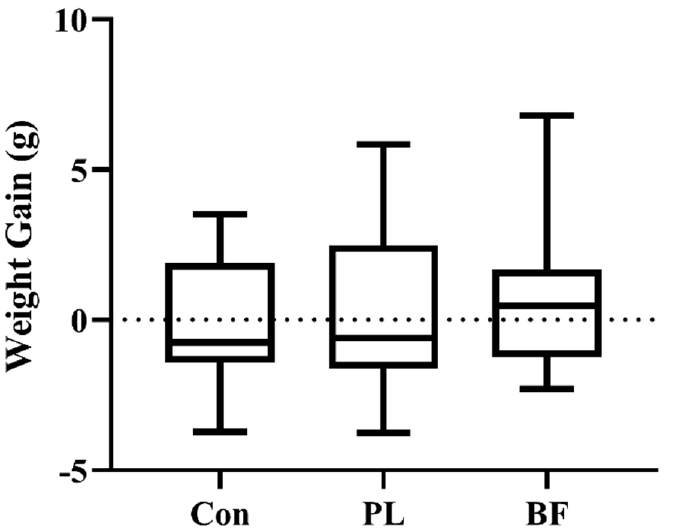
Figure 4. Effects of L. plantarum Y42 in the planktonic (PL) and biofilm (BF) states on weight gain in mice. All data are presented as mean ± SD ( n = 6 mice per group). Note: Con means control group; PL means planktonic group; BF means biofilm group.